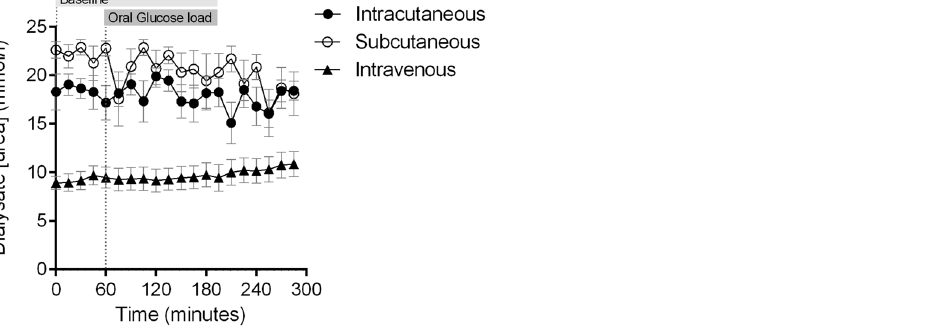
Figure 4. Mean changes in dialysate concentration of urea in the intracutaneous, subcutaneous and intravenous compartment after oral intake of 75 g glucose load in healthy subjects (N = 11). *Indicates a significant difference between the intra- and subcutaneous catheters. Error bars represent standard error of the mean